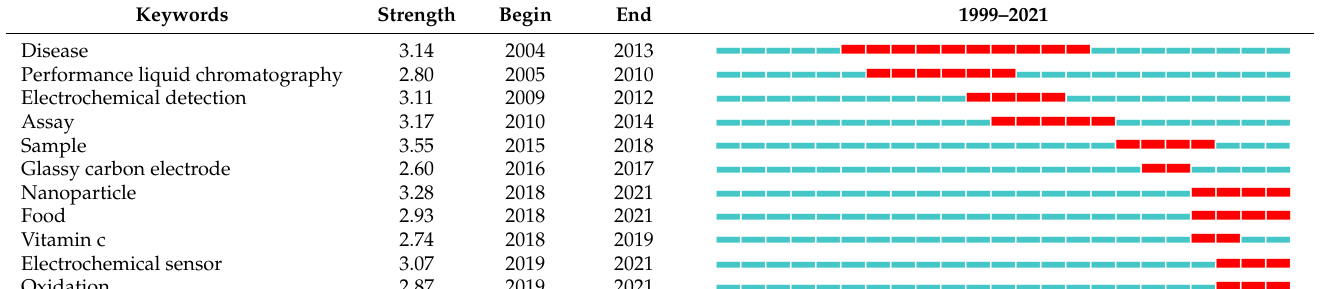
Table 3. 11 keywords with the strongest citation bursts during the research history of the evaluation of antioxidants using electrochemical sensors.